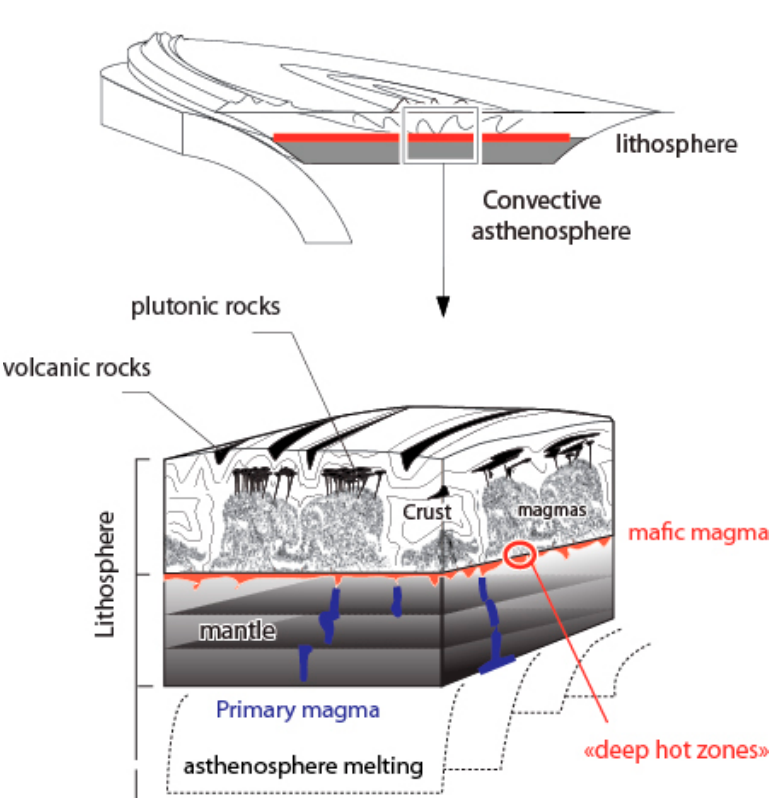
Figure 1. Schematic 3-D model of active margin hosting a “deep hot zone” that formed along the crust-mantle boundary.